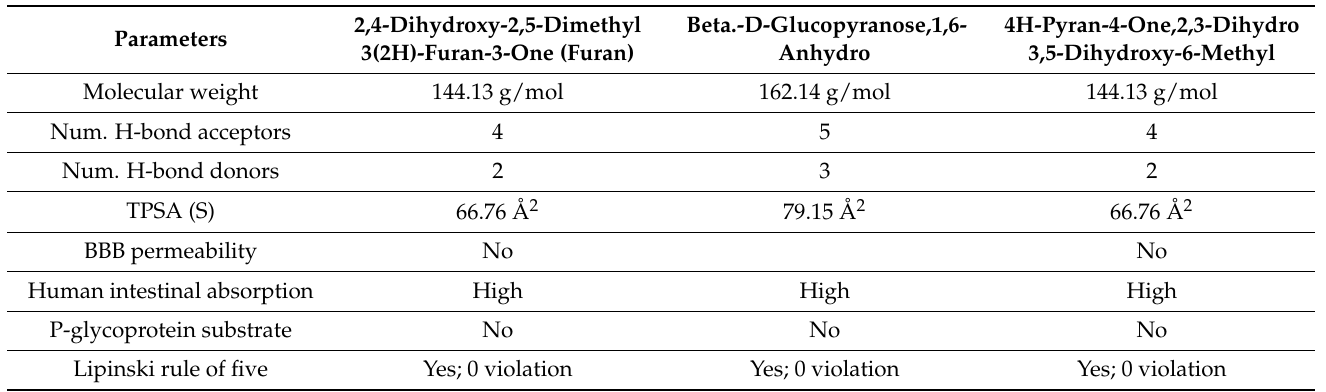
Table 6. The pharmacological assessment of the screened hit ligand